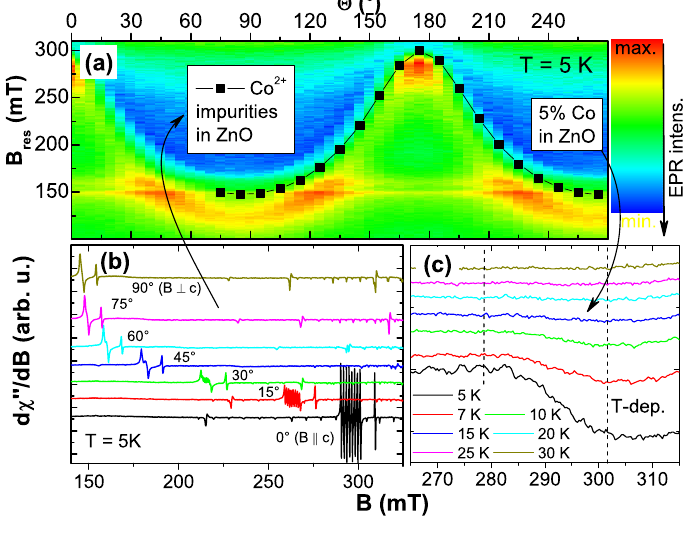
Figure 8. (a) EPR color-code plot recorded at 5 K of a 5% Co-doped ZnO sample grown by RMS as a function of the polar angle (cid:2) in comparison with Co 2+ -impurities in bulk ZnO (black squares). The hyperfine-split octet of the Co 2+ impurities is shown in (b); the broad resonance feature of the 5% Co:ZnO film vanishes quickly with temperature